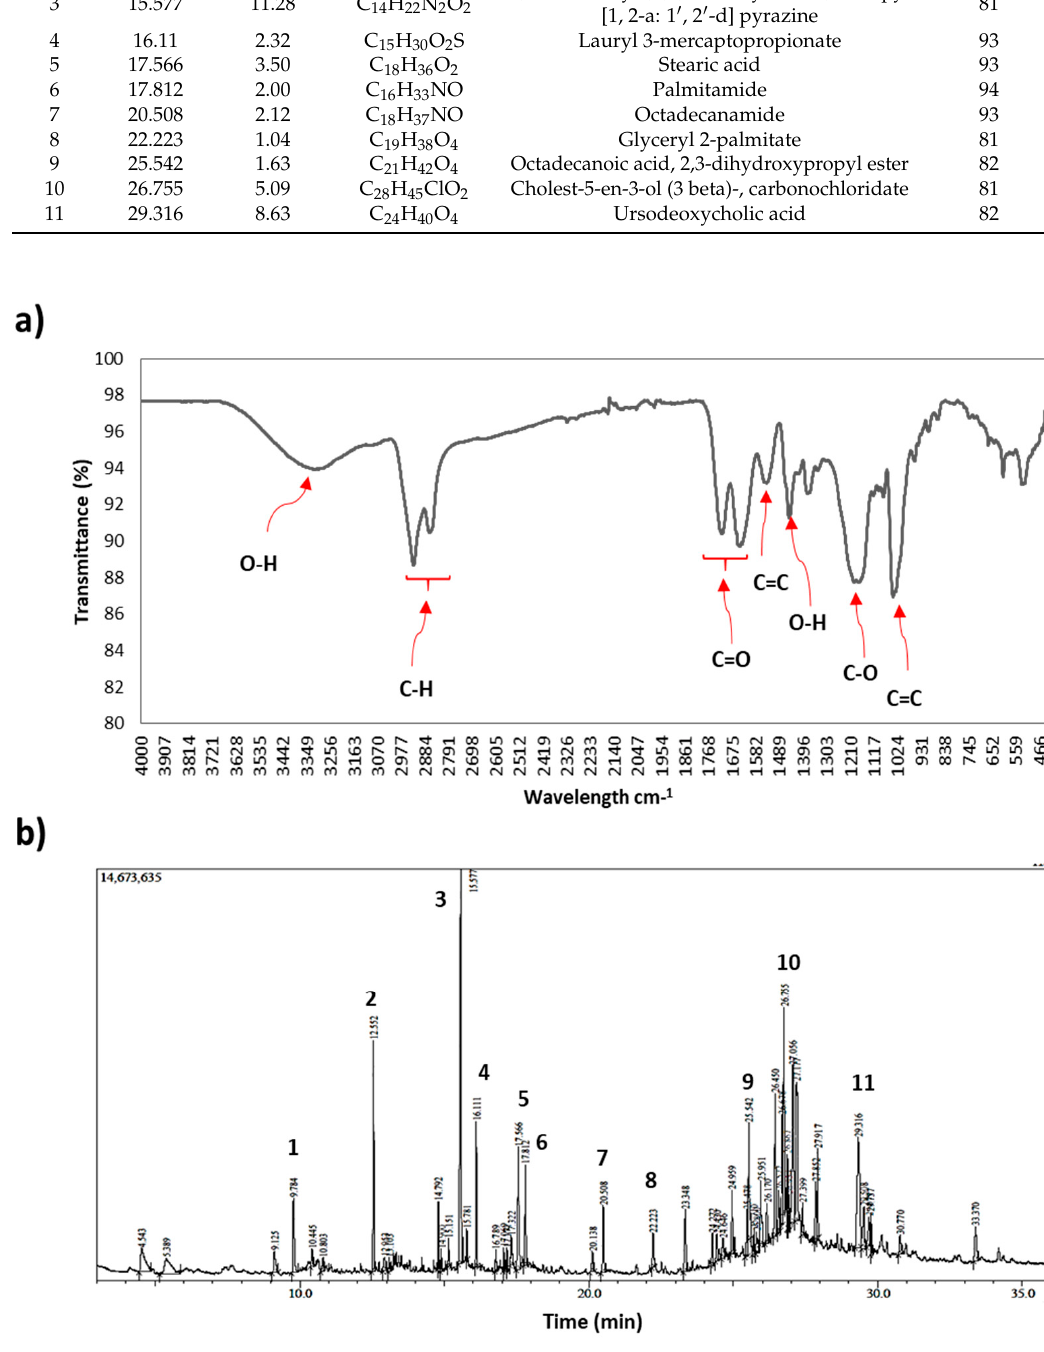
Figure 2. Porcupine bezoar chemical characterization. ( a ) The FTIR spectrum with its functional group detected. ( b ) The GCMS chromatogram of aqueous